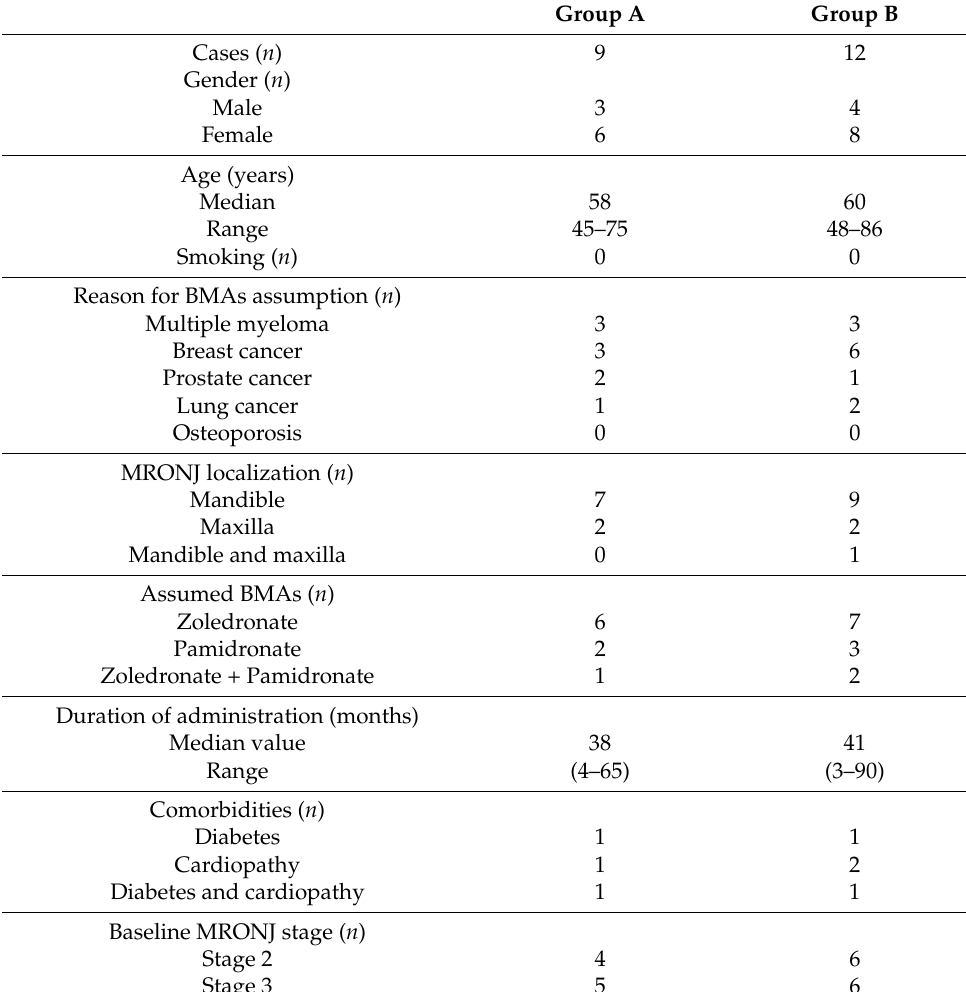
Table 2. Sociodemographic and disease-related